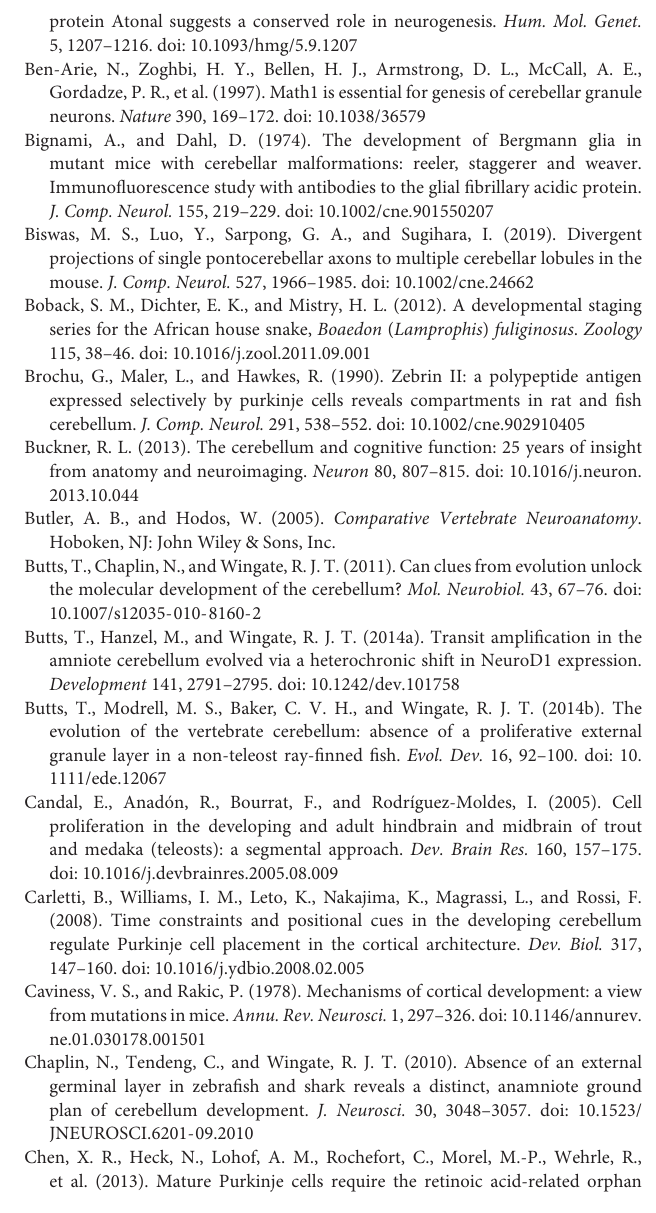
Supplementary Figure 1 | Molecular characterization of postnatal squamate cerebellum. (A,B) Double IHC for PCNA (green staining) and SHH (red) markers at 15 days post-hatching (dph) (A) or ISH for Rora at juvenile stage (B) in the cerebellum of P. vitticeps . The arrowhead in panel (A) indicates the position of the incomplete fissure on the cerebellar pial surface. Insets in (A) show high magnifications of proliferating GCPs (green) or SHH-positive PCs (red). (C,D) ISH for Rora (C) or Reln (D) in the cerebellum of juvenile B. fuliginosus . PS, pial surface; IGL, internal granule layer; VS, ventricular surface. Scale bars: 50 µ